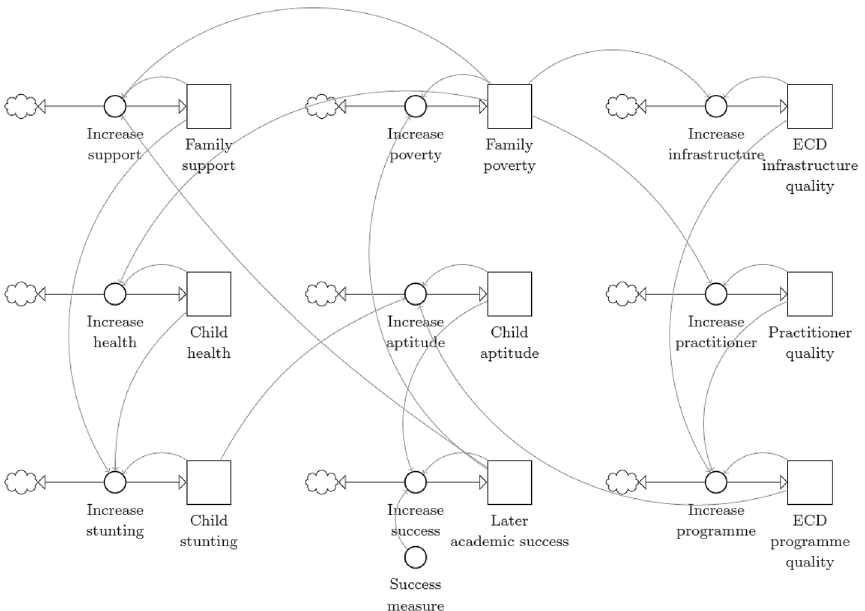
Fig. 2 Stock-and-flow diagram for the early childhood system in the